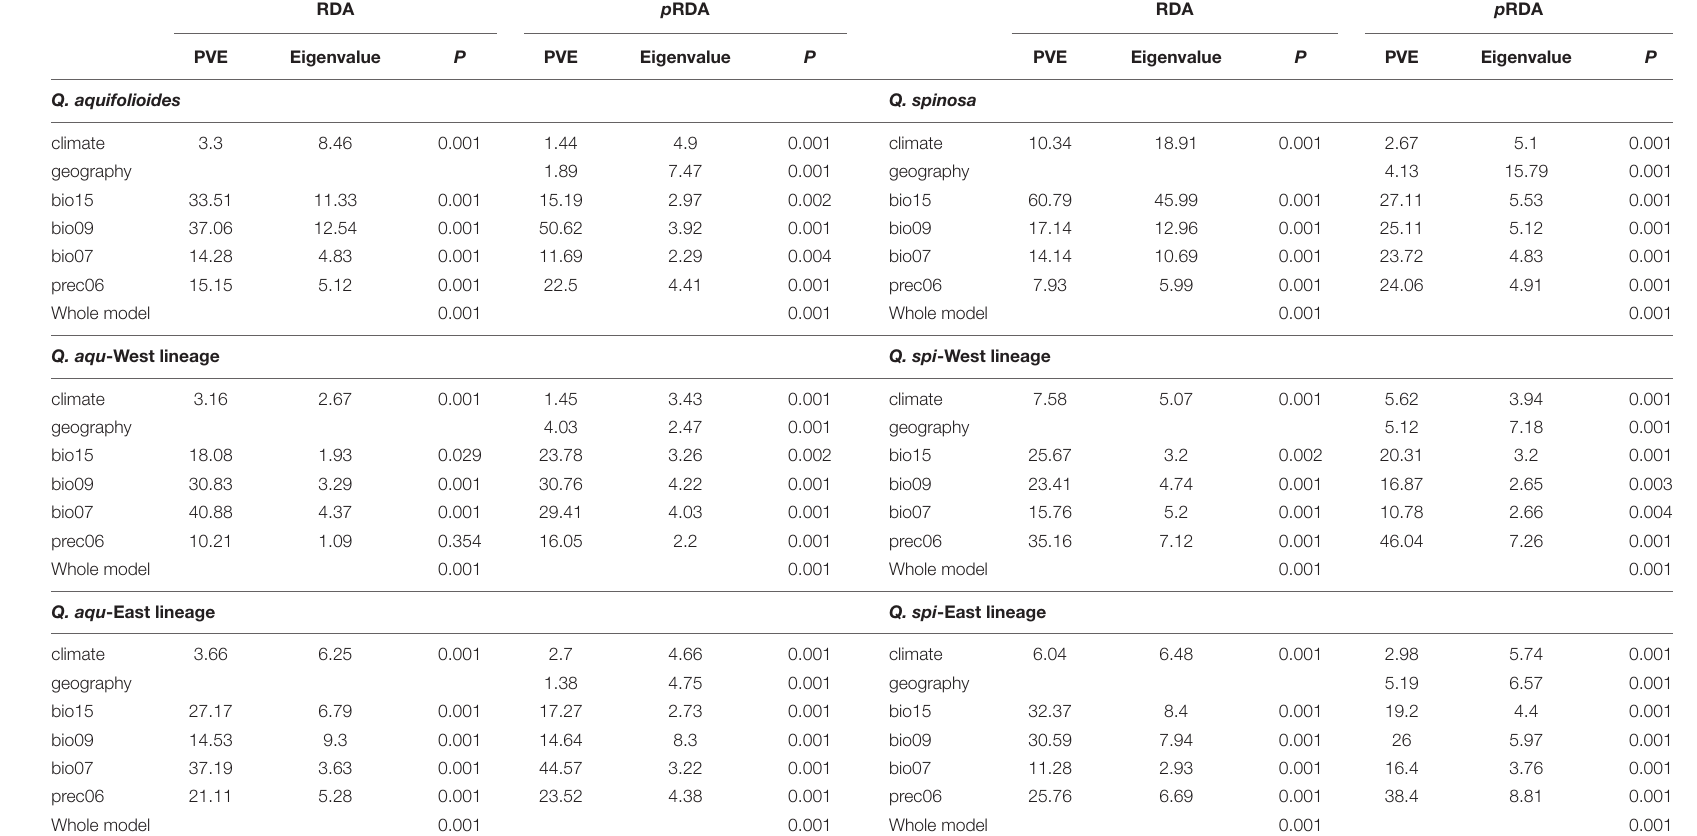
TABLE 5 | Summary of the genetic variations associated with climate and geographic variables based on RDA and p RDA in Q. aquifolioides and Q. spinosa . RDA p